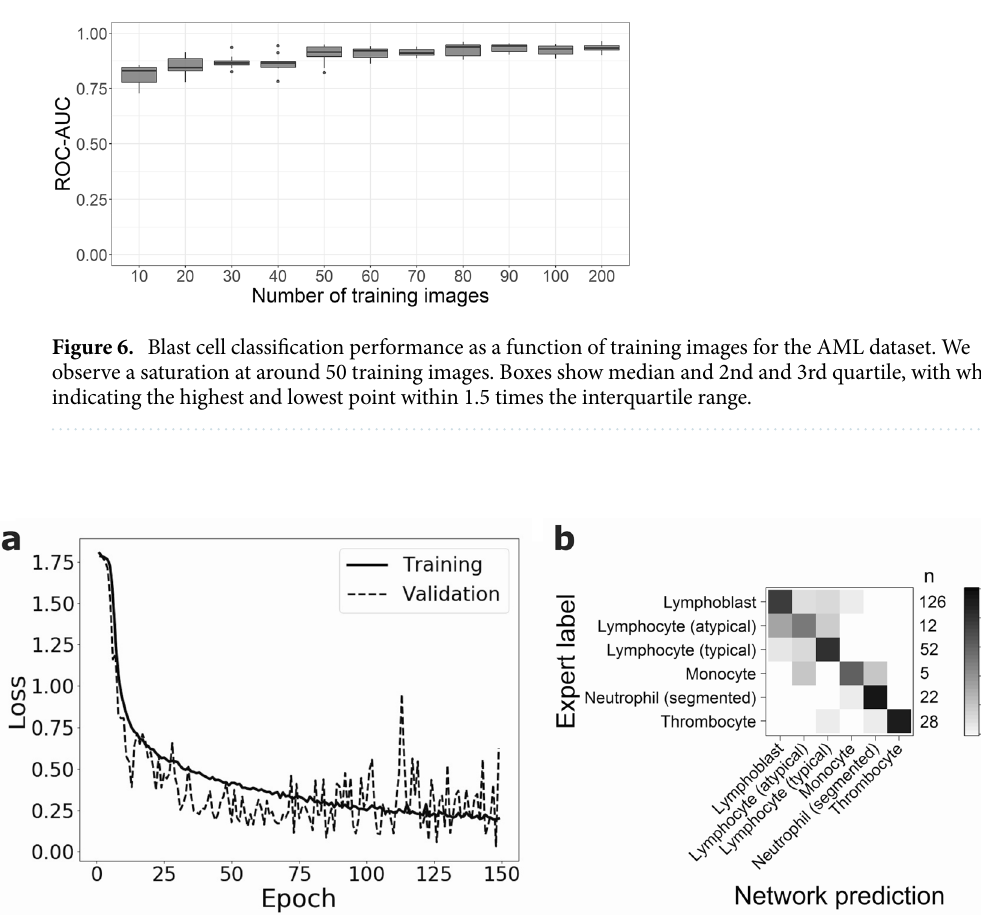
Figure 7. Multiclass classification of the ALL dataset using 200 training images. ( a ) Decrease of validation and training loss during training of one of the ten folds. Classification of the test set results in an F1-score of 0.81 ± 0.09 (mean ± s.d., n = 10 folds). ( b ) Confusion matrix visualizing the percentage of network predictions in each class. On the right hand side of the matrix the number of images in each class is given. In each class, 50% (in the case of atypical lymphocytes) or more cell images are classified correctly. Atypical lymphocytes (n = 12) and monocytes (n = 5) have the lowest number of images and show the most